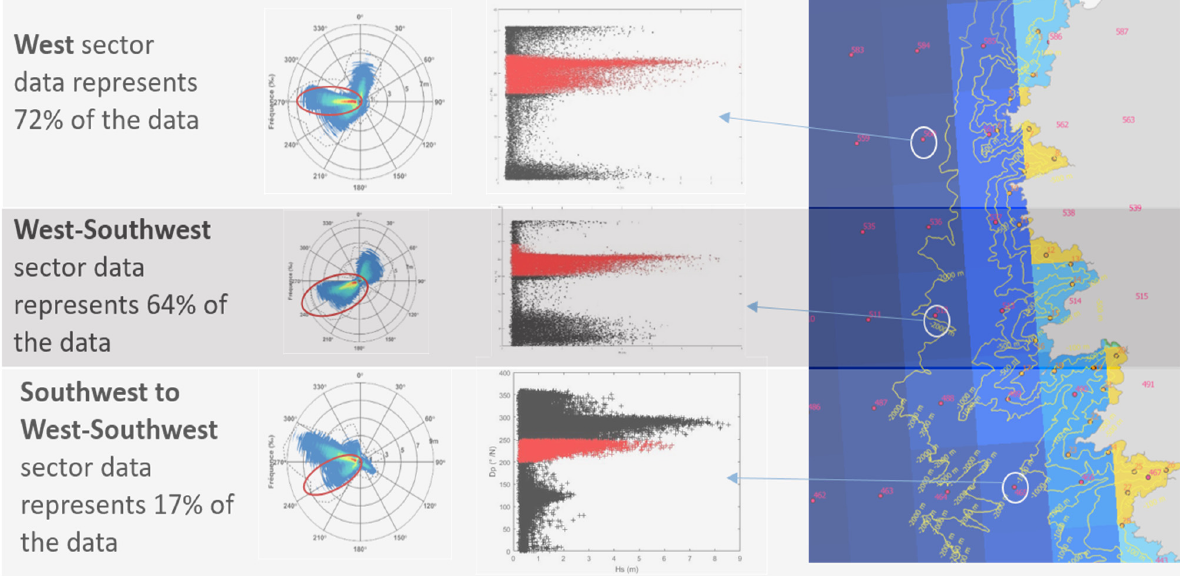
Figure A4. Wave roses; and Dp(°) plotted against Hs(m) for three offshore points. The red dots and red circles indicate the wave directions, which could most affect the coastline for extreme conditions regarding the coast morphology.